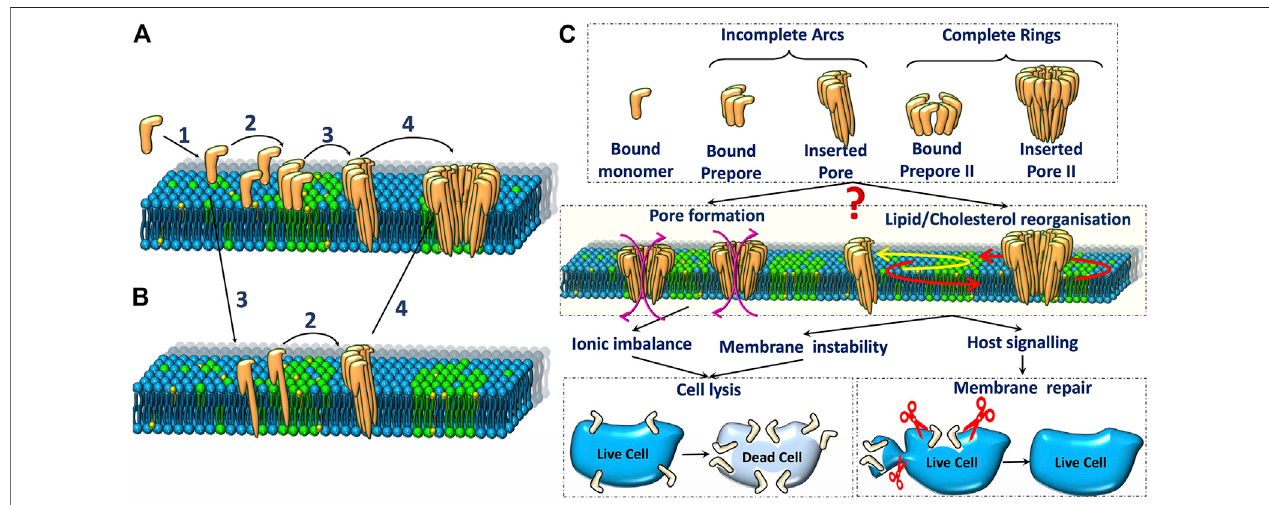
FIGURE2| Schematicrepresentationoftwomajorporeformationpathways (A , B) ofporeformingtoxins.Thevariousstepsin (A) are1.BindingofPFTstothelipid bilayer,2.Oligomerisationofmonomerstoformarcorring-likepreporestructures,3.Membraneinsertion,4.Oligomerisationofinsertedpores(observedinsomecases). (C) . Various oligomeric states (top) and their in fl uence on ionic imbalance and lipid reorganization (middle) triggers downstream repair processes which could result in either cell death or repair (bottom) .